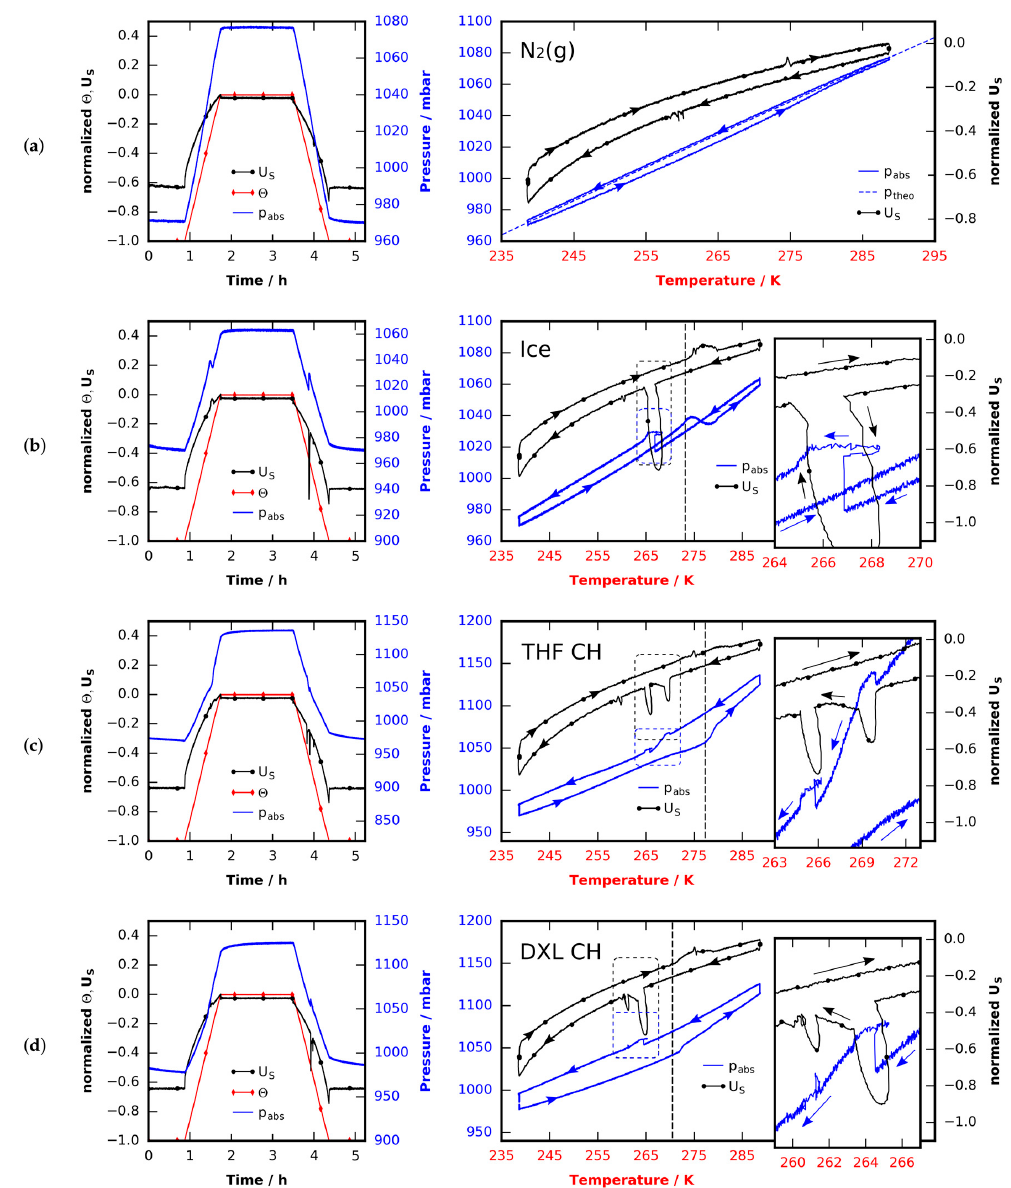
Figure 1. Pressure p abs , temperature Θ , and supply voltage U S obtained from four similar experiments done with four different samples. The samples were loaded under a dry nitrogen flow at 298 K and cooled to 238 K. The nitrogen flow ensured a dry and well defined atmosphere inside the cell. During the initial cooling phase (not shown) the cell was opened several times to compensate for thermal contraction of the gas and to ensure a constant initial pressure. After a waiting period of 30 min at 238 K the experiments were started and the data was recorded: the temperature was controlled and guided along a trapezoidal temperature profile with a bottom temperature of 238 K, a top temperature of 288 K, and a slope of 1 K/min. This was done with: ( a ) an empty cell solely filled with gaseous nitrogen; ( b ) an ice sample with mass 250 mg; ( c ) a THF clathrate sample (mole fraction 1:16.65) with mass 250 mg; and ( d ) a DXL clathrate sample (mole fraction 1:16.65) with mass 250 mg. Horizontal dashed black lines indicate the theoretical melting points of the substances used.